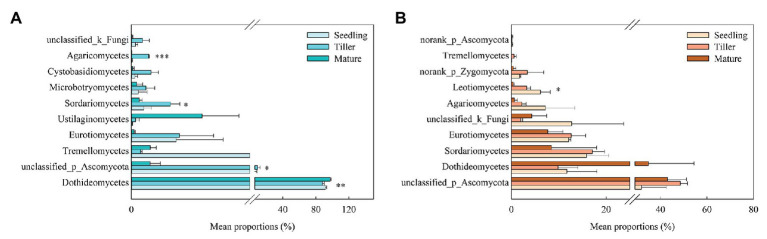
Relative abundances of top 10 fungal classes that showed significant differences among phyllosphere (A) and rhizosphere (B) samples from the seedling, tiller, and mature stages. A one-way ANOVA was used to evaluate the significance of differences between the indicated groups. *p < 0.05; **p < 0.01; ***p < 0.001.